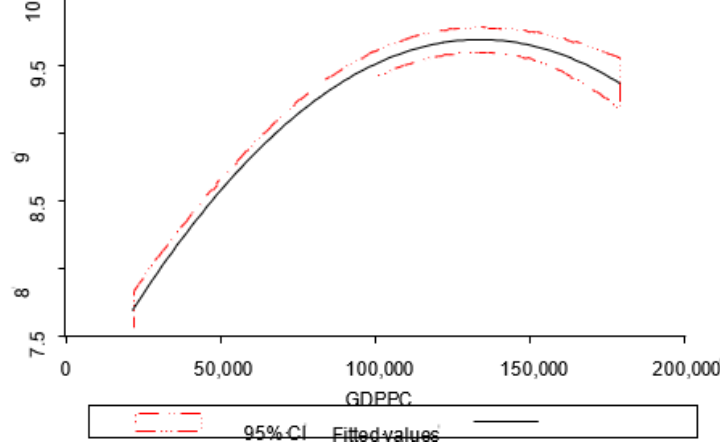
Figure 1. Relationship between GDP per capita and Carbon emissions